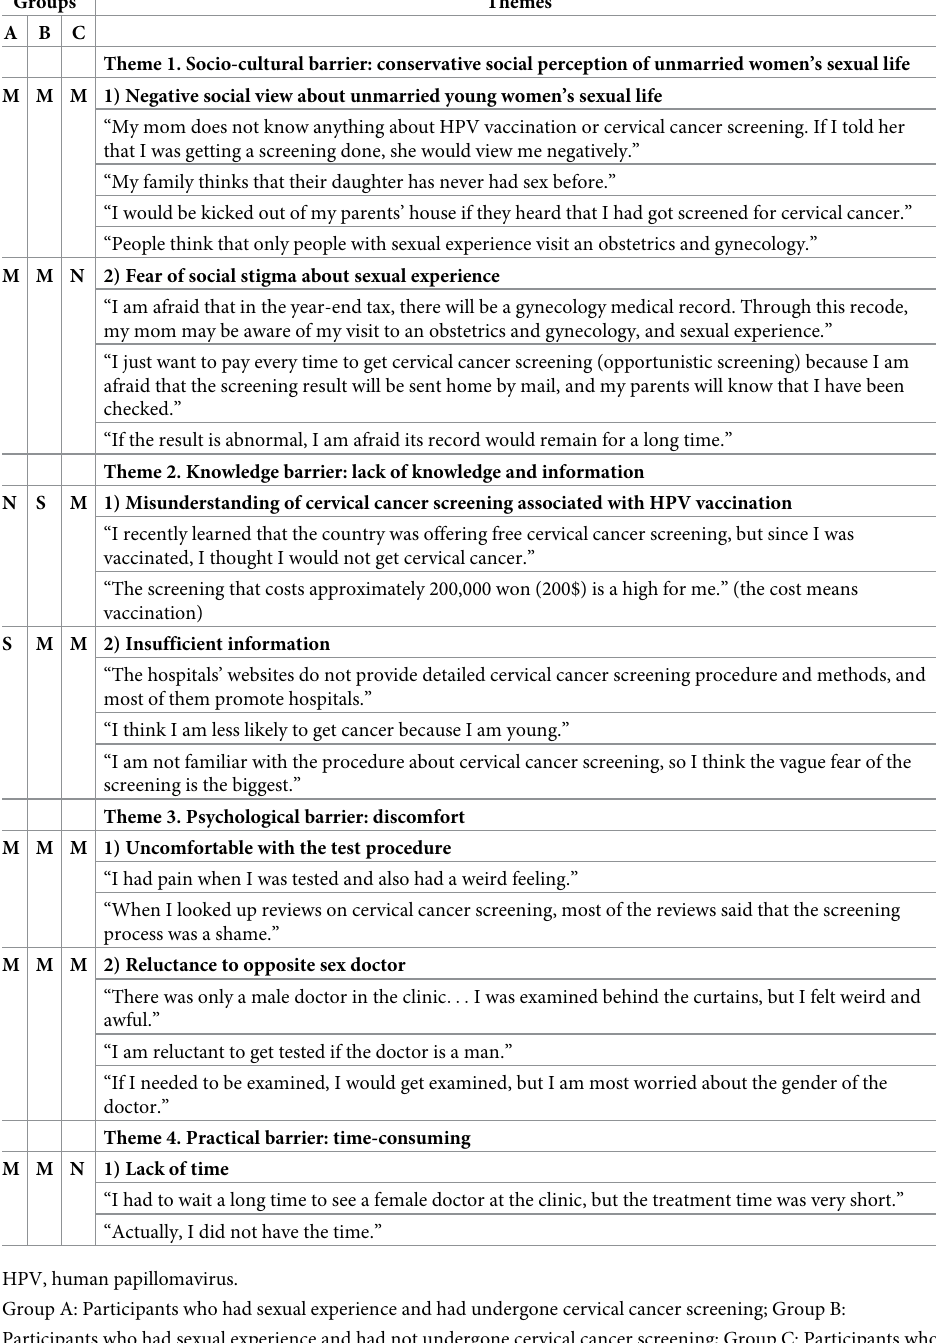
Table 2. Barriers to participation in cervical cancer screening (N =